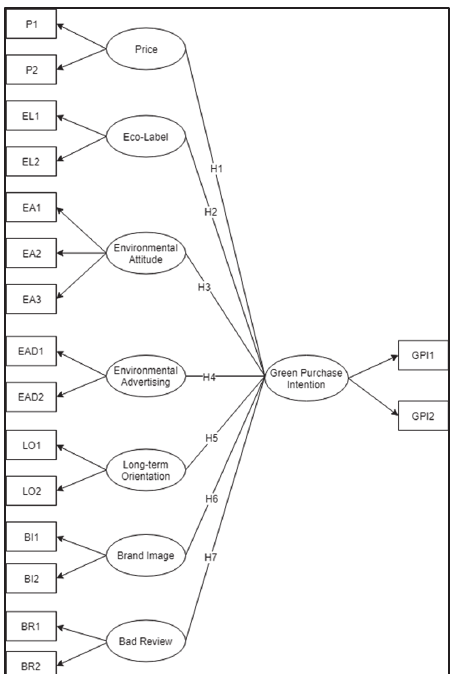
Fig. 2. Conceptual